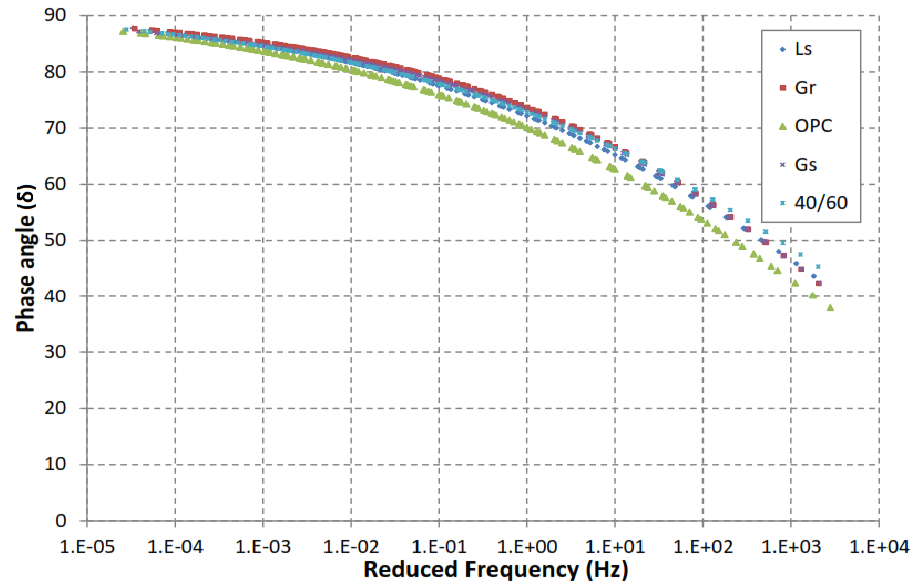
Figure 6. Phase angle master curves of mastics.